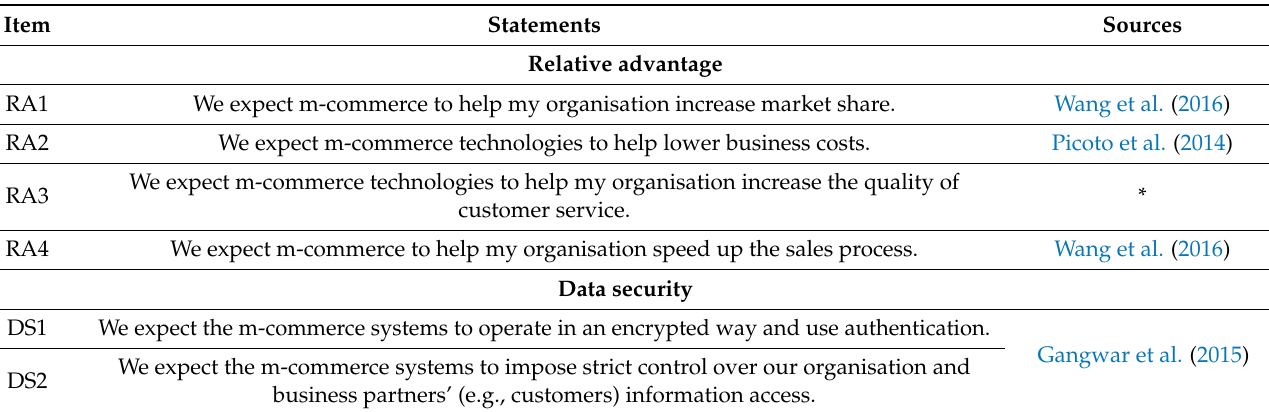
Table A2. Technological context.